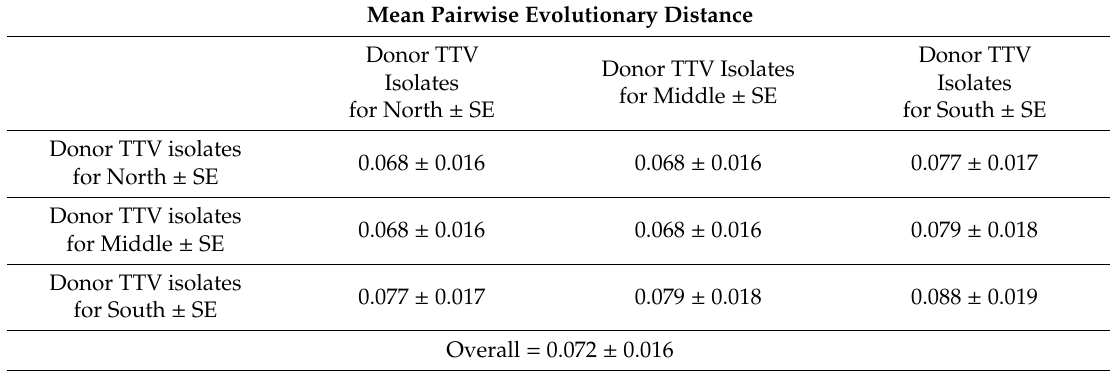
Table 7. Estimates and standard errors (SE) of mean evolutionary distance and diversity within and between blood donor TTV isolates from the North, Middle and South regions of Jordan.